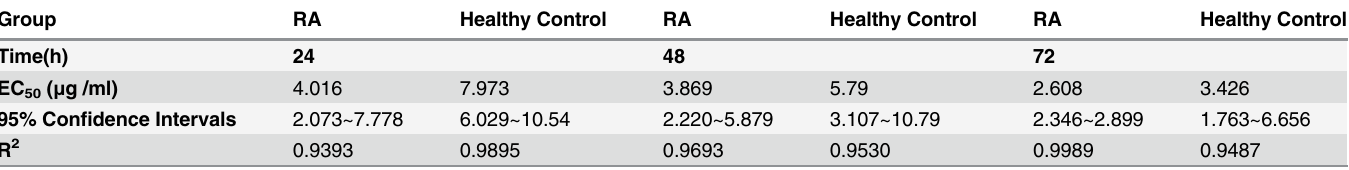
Table 3. Comparison of stimulating effect of IgD between RA patients and healthy controls. Group RA Healthy Control RA Healthy Control RA Healthy Control Time(h) 24 48